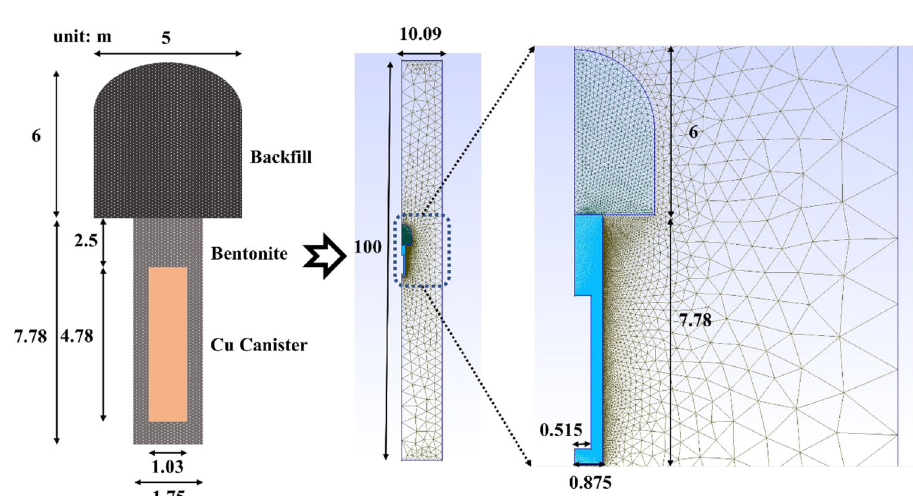
Fig. 20 Simpli fi ed geometry of deep geological repository. KAERI reference disposal unit, 2-D geometry of numerical model, and geometry of expanded around engineering barriers.